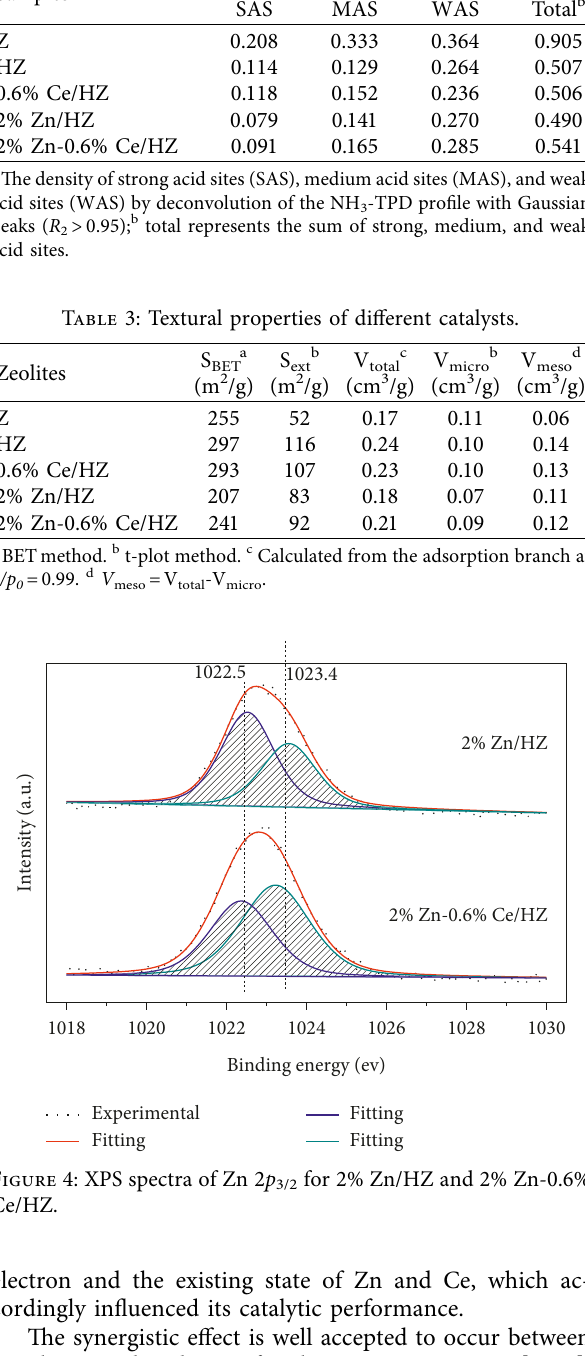
Table 2: Acidic properties of different catalysts. Samples